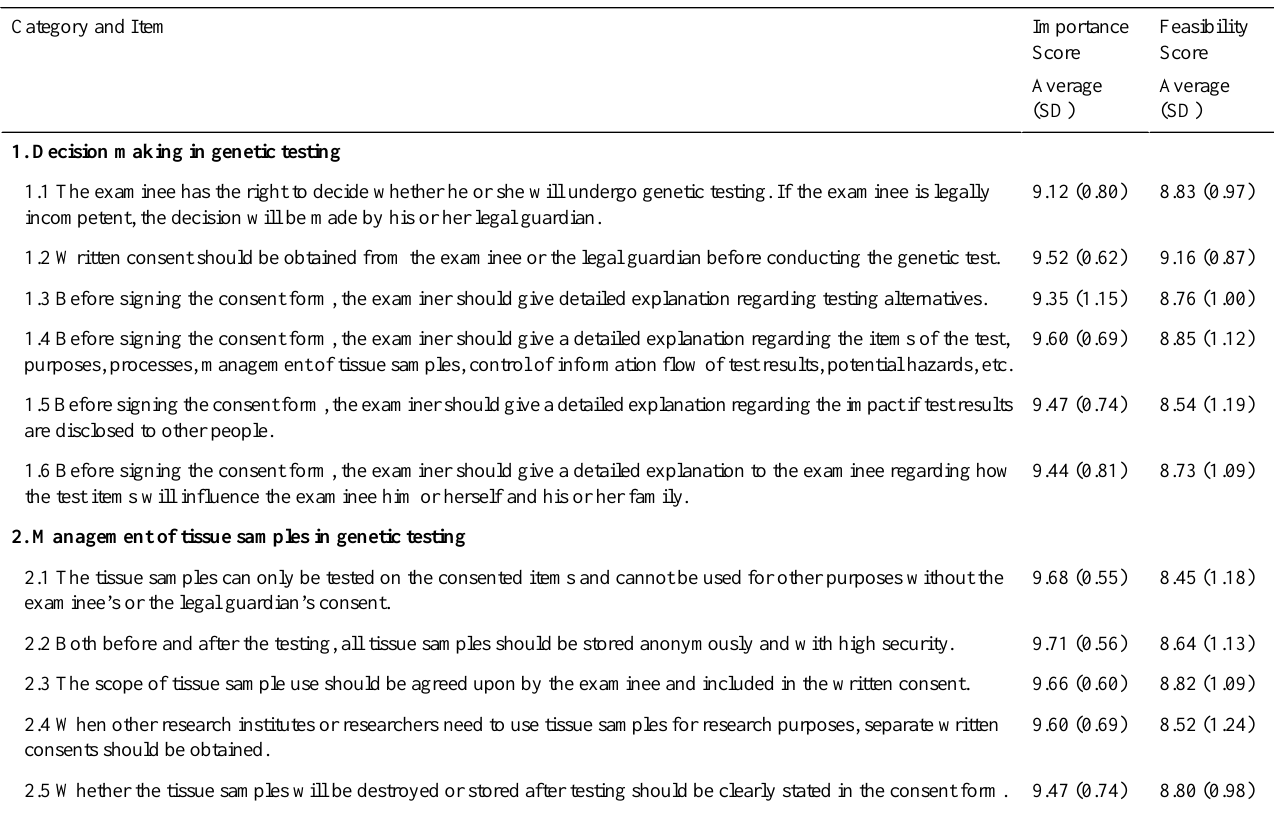
Table 3. The final Delphi results of the draft ethical guidelines